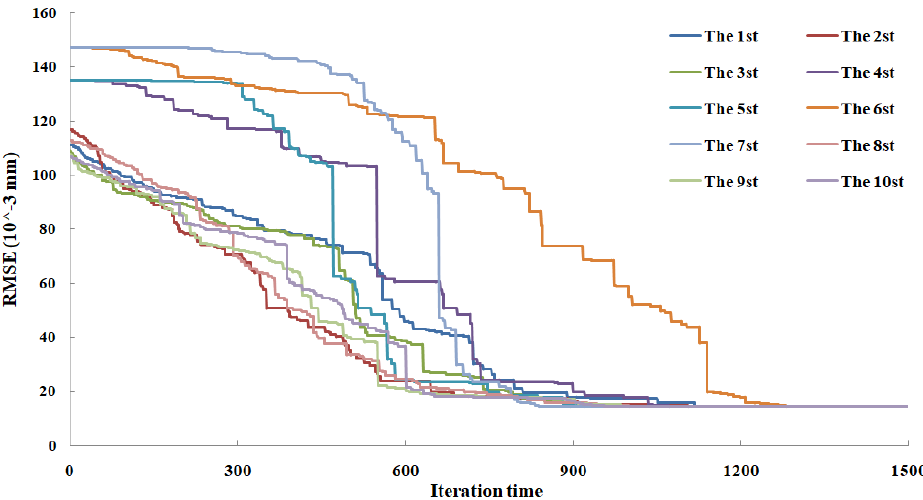
Figure 7. The optimal process of the objected function.